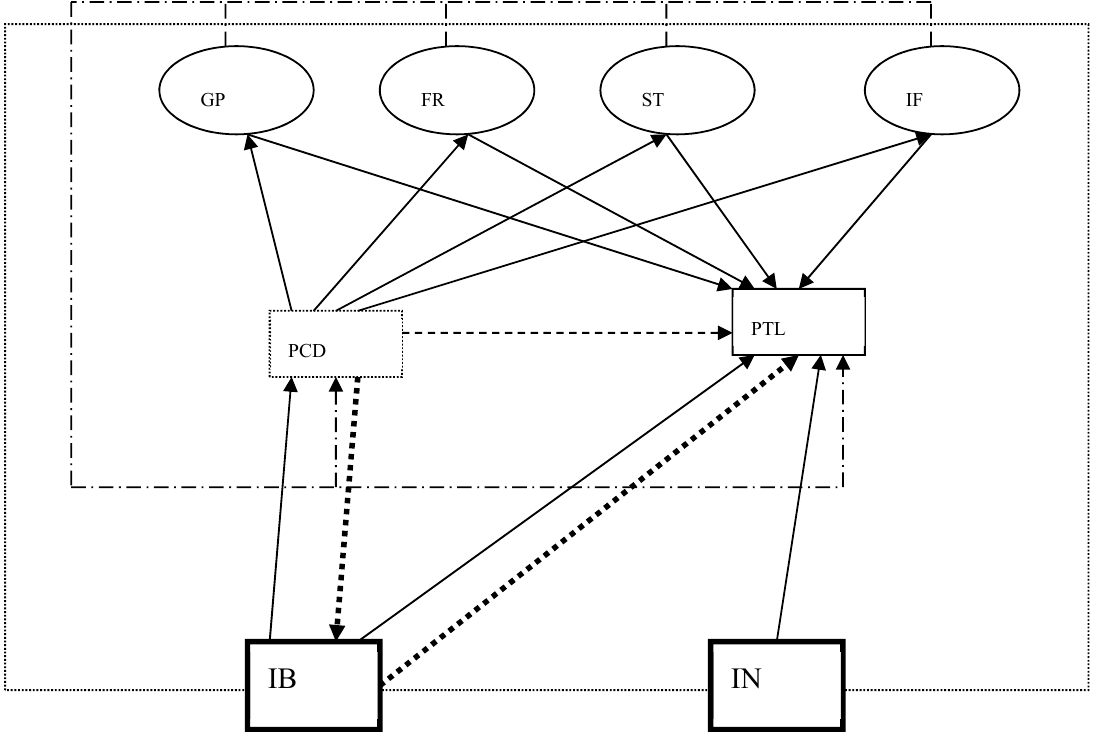
Figure 3. Summary of the components and interactions within the financial placement network.